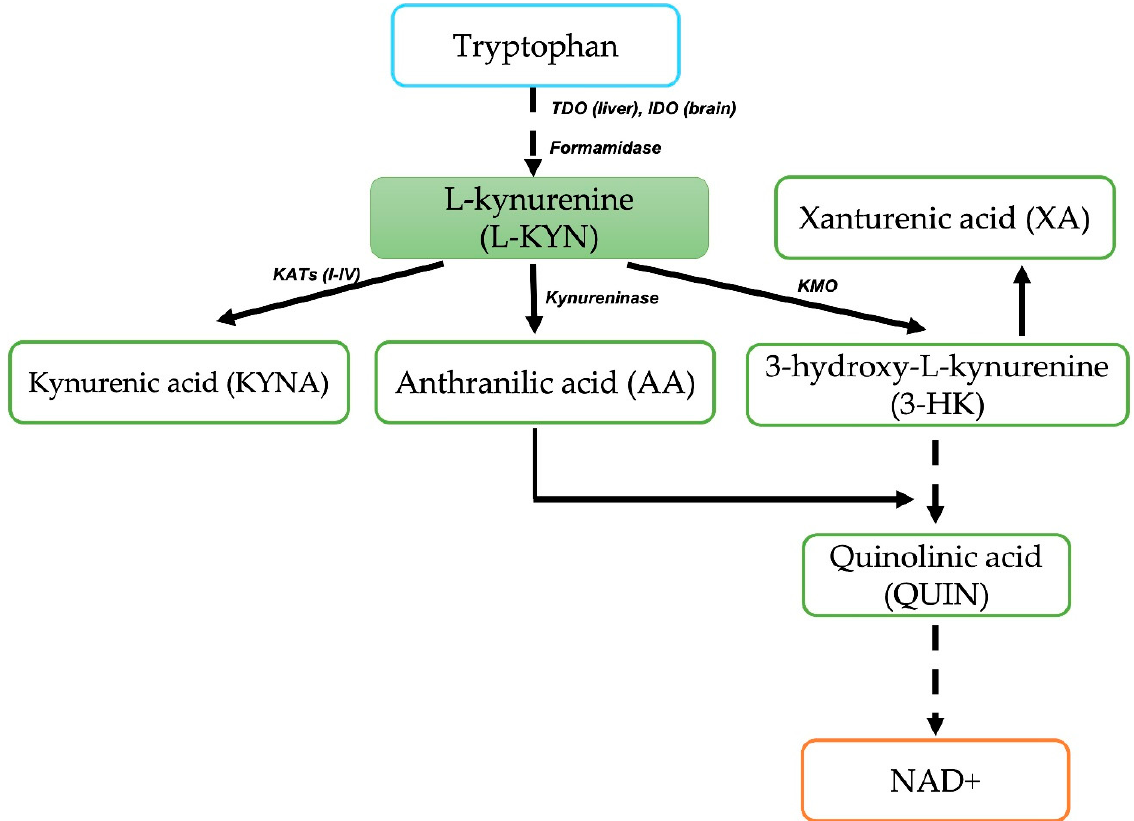
Figure 1. Kynurenine Pathway. The major catabolic route of tryptophan metabolism showing the main metabolites and enzymes conducing to the essential enzyme cofactor NAD+. TDO = trypto- phan 2,3-dioxygenase; IDO = indoleamine 2,3-dioxygenase; KAT’s = kynurenine aminotransferases; KMO = kynurenine-3-monooxygenase; NAD+ = nicotinamide adenine